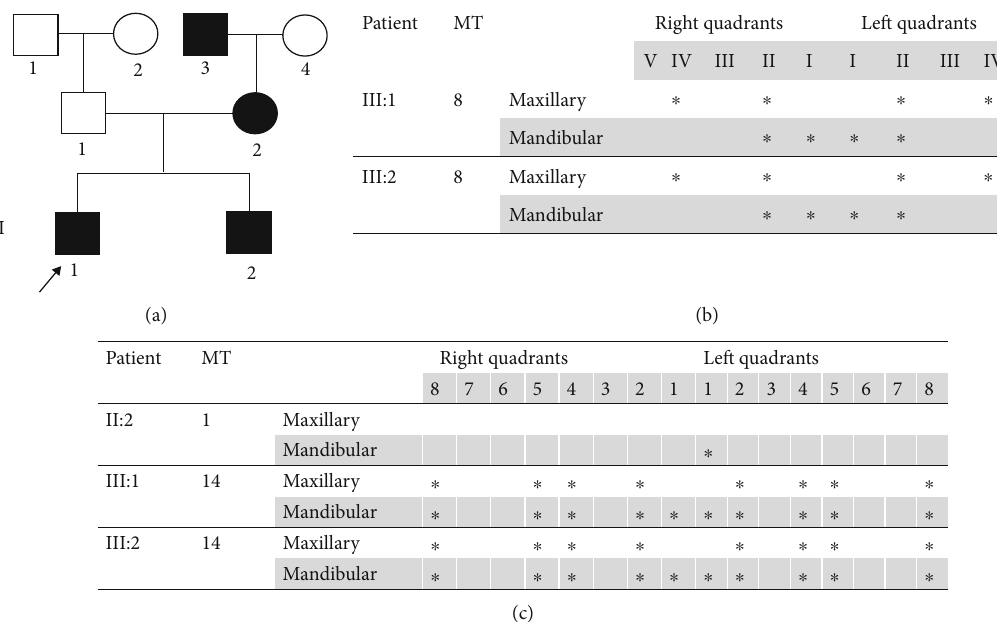
Figure 1: (a) Pedigree of the family. Males are shown as squares, and females are shown as circles. An arrow indicates the proband individual, and the black symbols indicate the a ff ected individuals. (b) Summary of the missing primary teeth of the two male patients who had panoramic radiographs. (c) Summary of the missing permanent teeth of the three patients who had panoramic radiographs. MT: missing teeth.